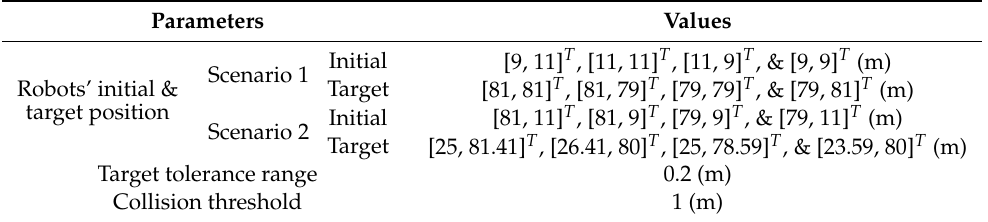
Table 2. Simulation parameters for